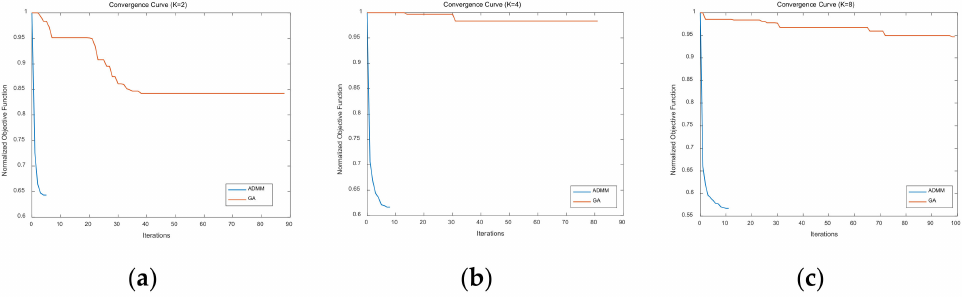
Figure 8. Convergence speed of the LSW-ADMM algorithm and the GA algorithm. ( a ) K = 2. ( b ) K = 4. ( c ) K =